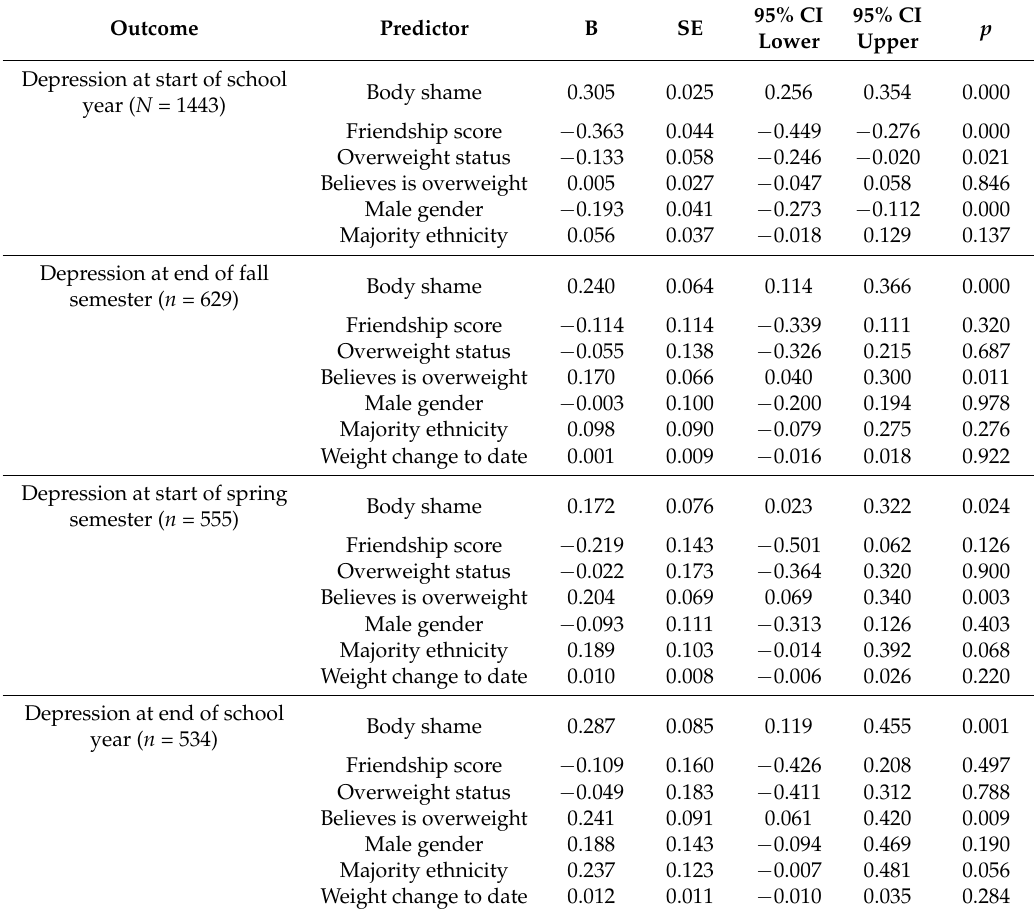
Table 2. Regression predicting levels of depressive symptoms across four study